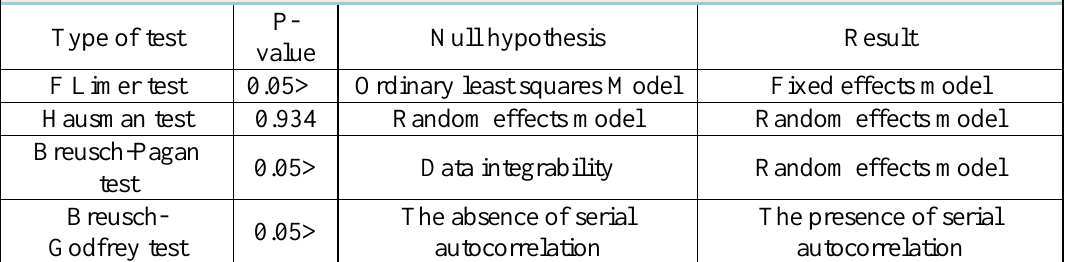
Table 2. The summary of diagnostic tests for the best regression model for panel data fitting